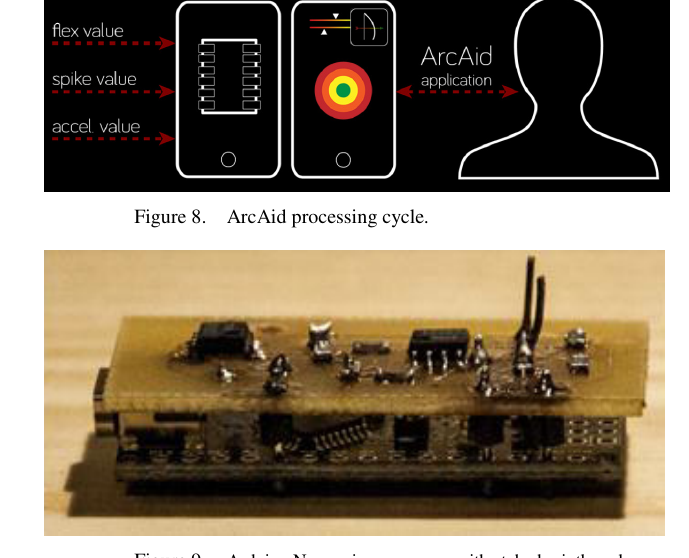
Figure 9. Arduino Nano microprocessor with etched